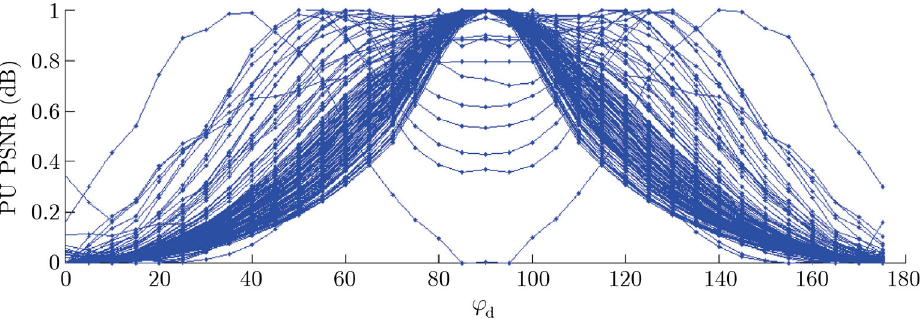
Fig. 2 Normalized BRDF reconstruction error PU PSNR [40] (normalized to [0,1]) as a function of constant ϕ d used for data reduction.